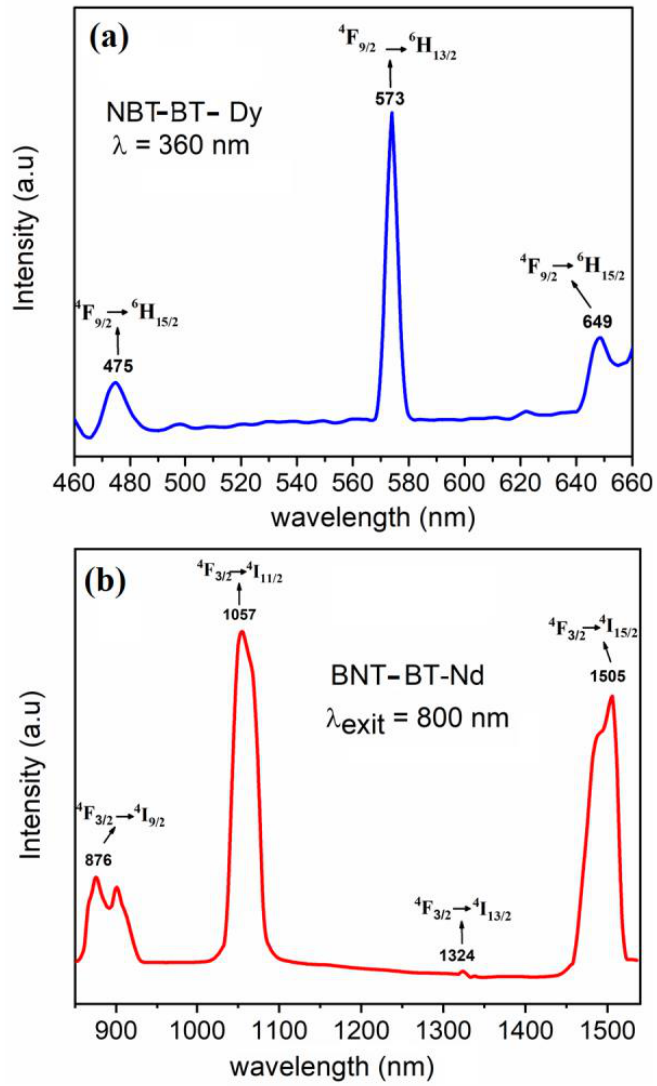
Figure 9. The emission spectrum of ( a ) BNT–BT–Dy after excitation at λ ext = 360 nm, and ( b ) BNT–BT–Nd excited at λ ext = 800 nm.